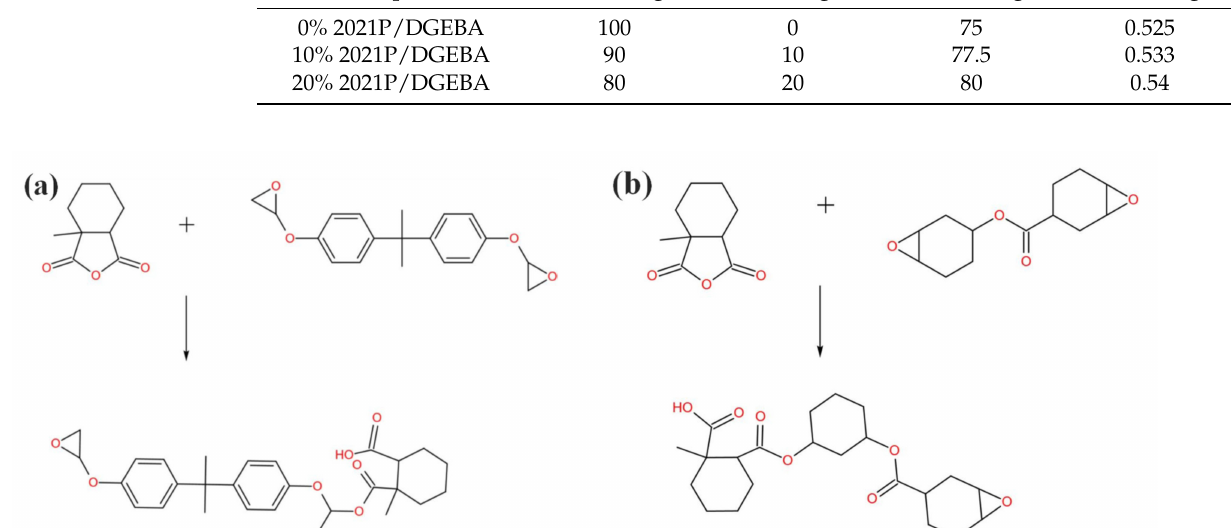
Figure 1. Schematic diagram of curing reaction ( a ) Curing schematic diagram of DGEBA and MHHPA ( b ) Curing schematic diagram of 2021P and